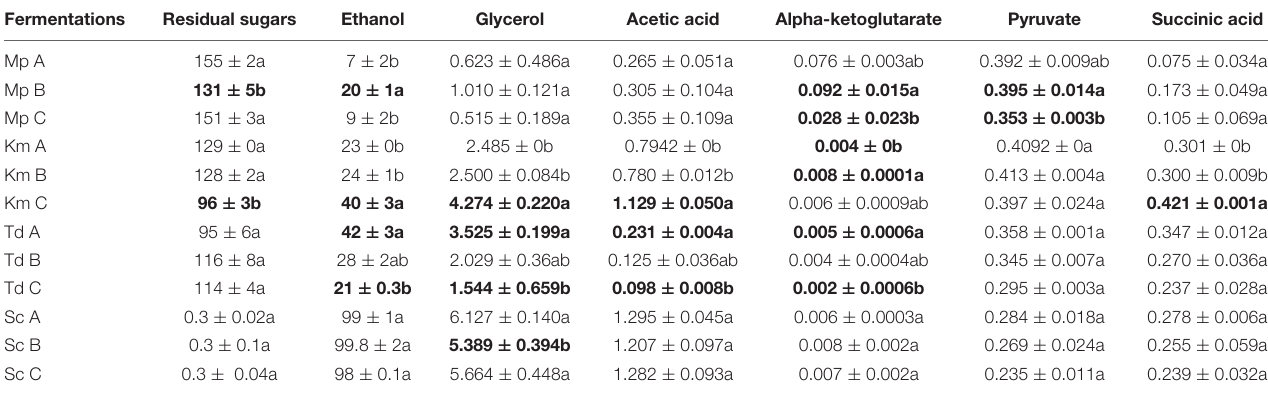
TABLE 3 | Residual sugars and fermentation derived metabolite production in Medium A containing an equimolar lipid composition, Medium B with double the amount of unsaturated fatty acids and Medium C with a grape juice-like lipid composition when fermentations were terminated (g/l). Fermentations Residual sugars